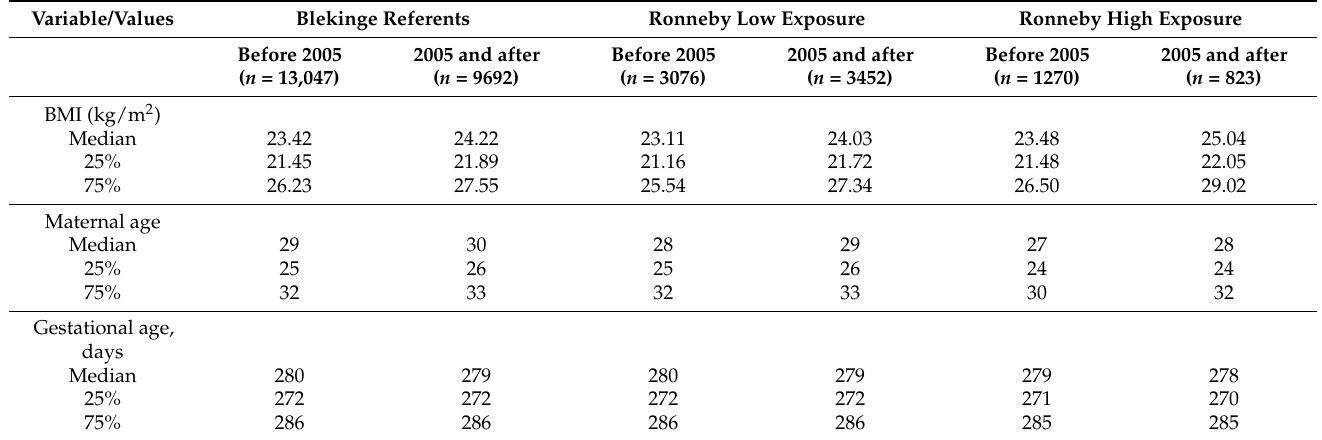
Table 2. Descriptive data by exposure group and period, continuous variables.